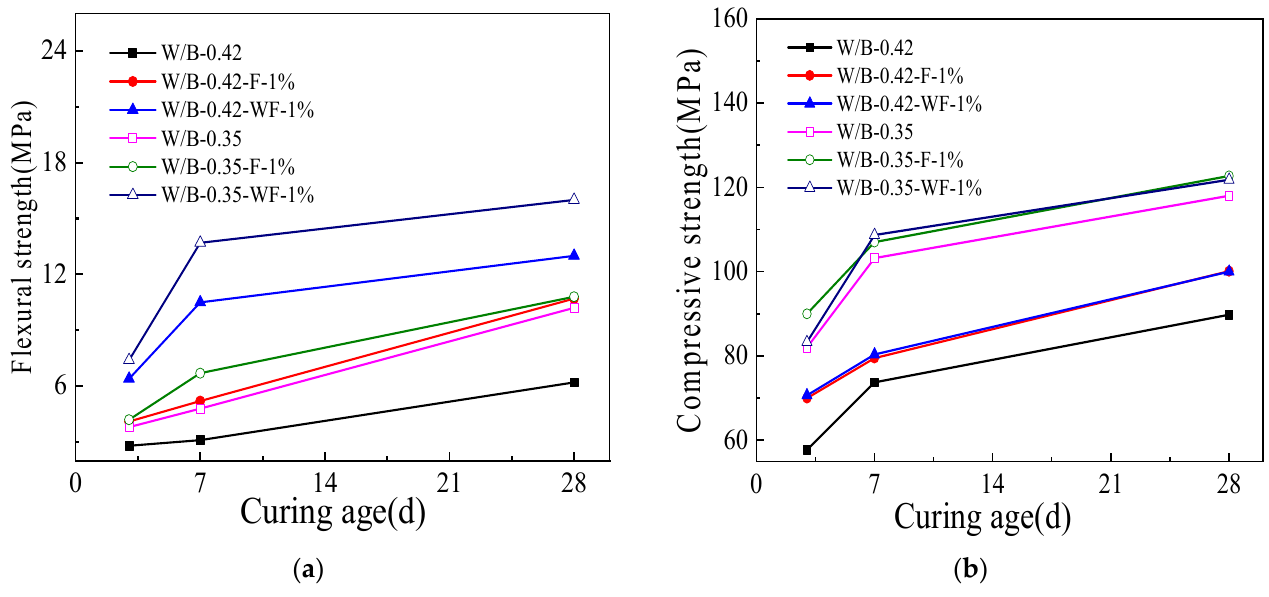
Figure 3. The mechanical strengths with different curing age. ( a ) Flexural strength. ( b ) Compressive strength.